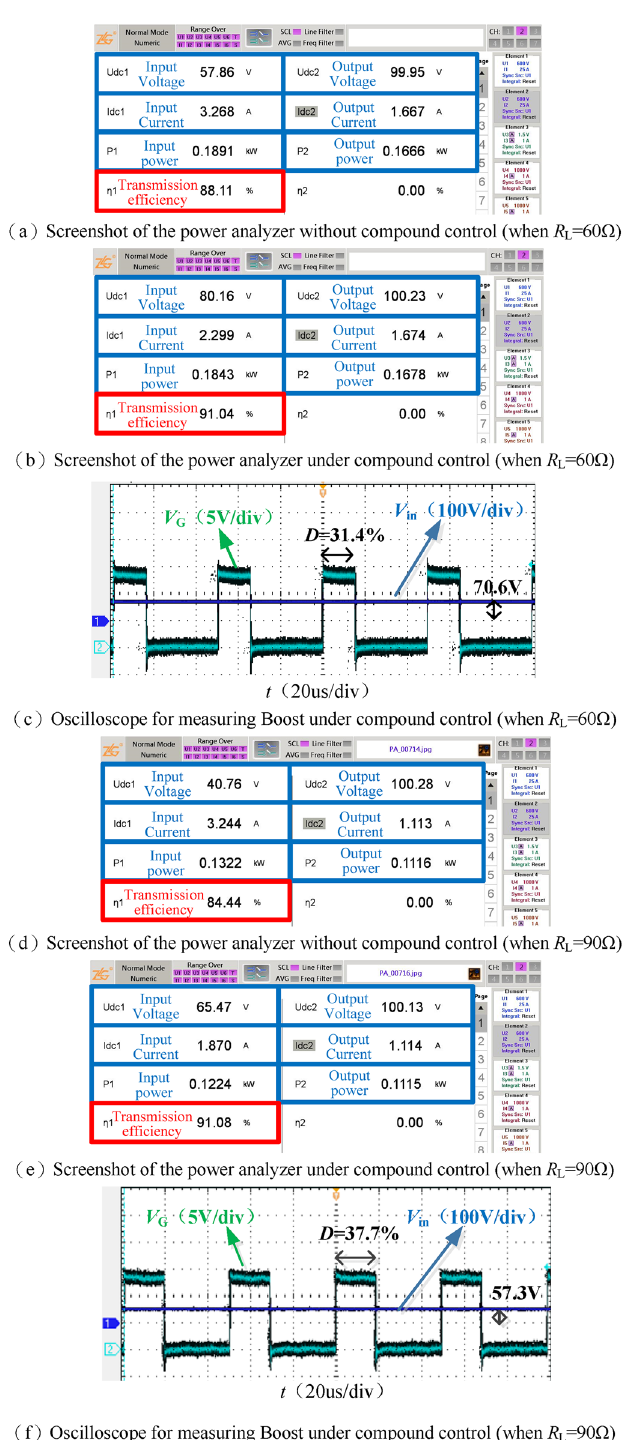
Figure 19. Main data and waveforms when R L = 60 Ω, R L = 90